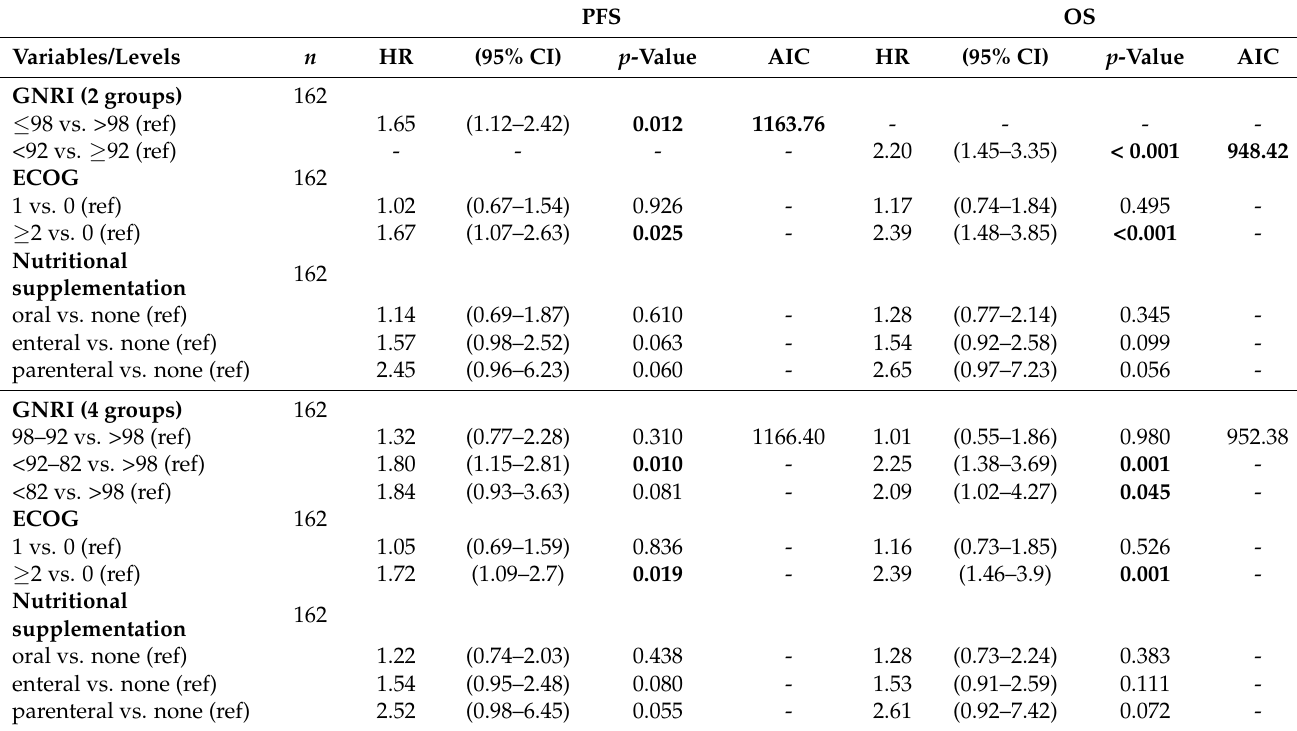
Table 4. Multivariable Cox regression for PFS, OS and respective AIC analysis. PFS